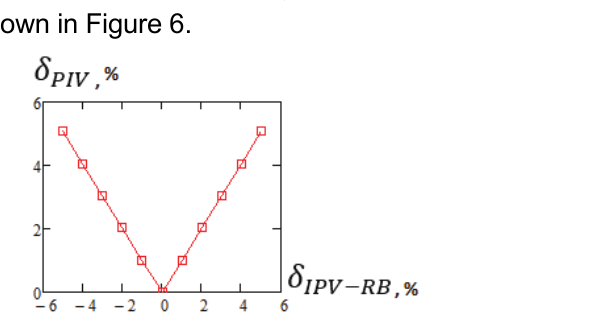
Figure 6 – Change in the PIV error of a projectile ( PIV  ) as a function of the assessment of the IPV on the right boundary RBIPV 